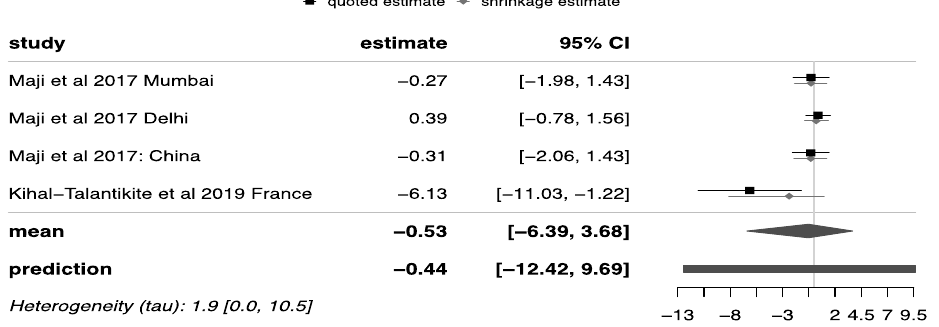
Figure 5. Forest plot PM10. The values of the forest plots indicate the log mortality rate mapped to their corresponding normal distribution values.